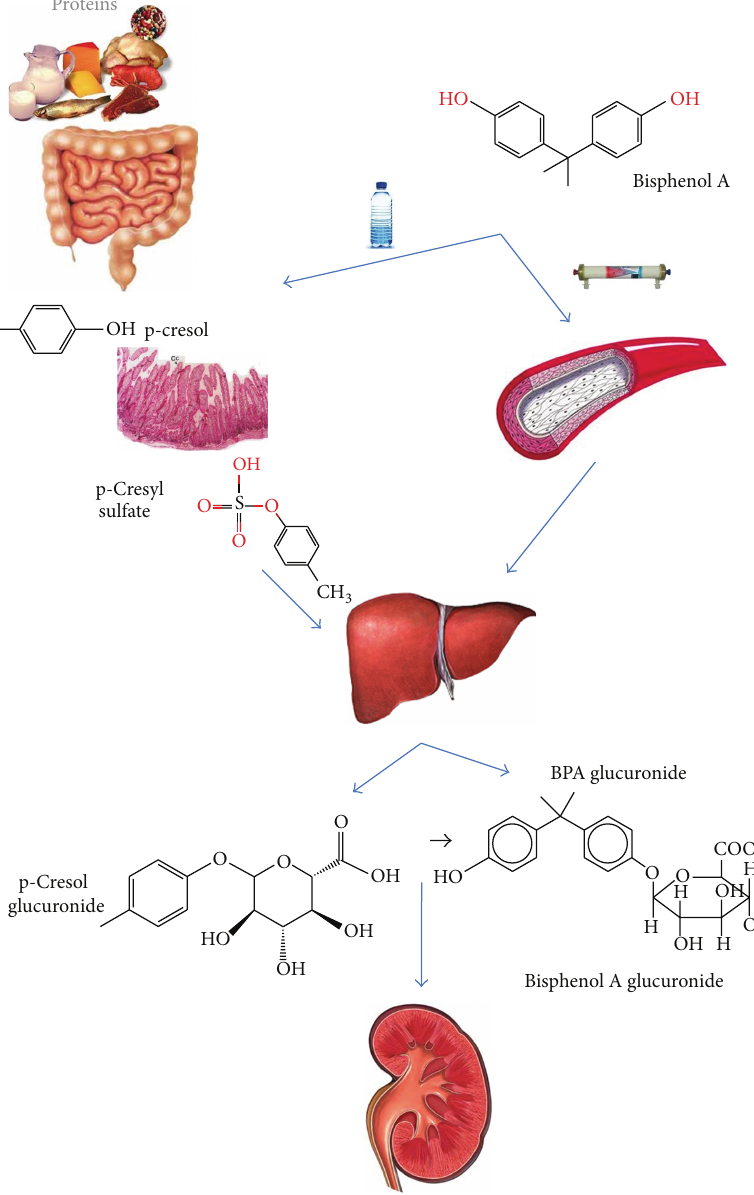
Figure 2: Origin and metabolism of microbial (p-cresol) and environmental (BPA) phenols. Both can be absorbed in the digestive tract, conjugated in the liver, and eliminated by the kidneys. BPA may also enter the blood from dialysis